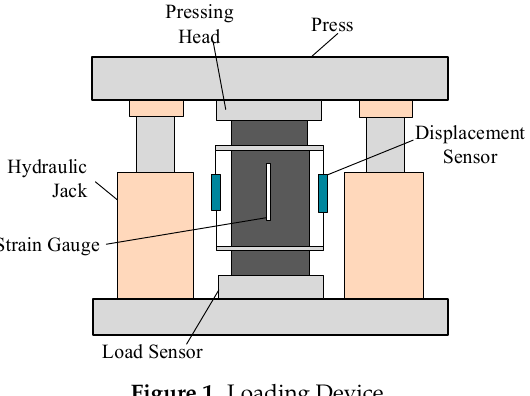
Figure 1. Loading Device.